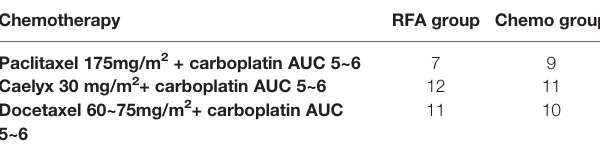
TABLE 1 | Chemotherapy treatment for liver metastasis in the two groups.